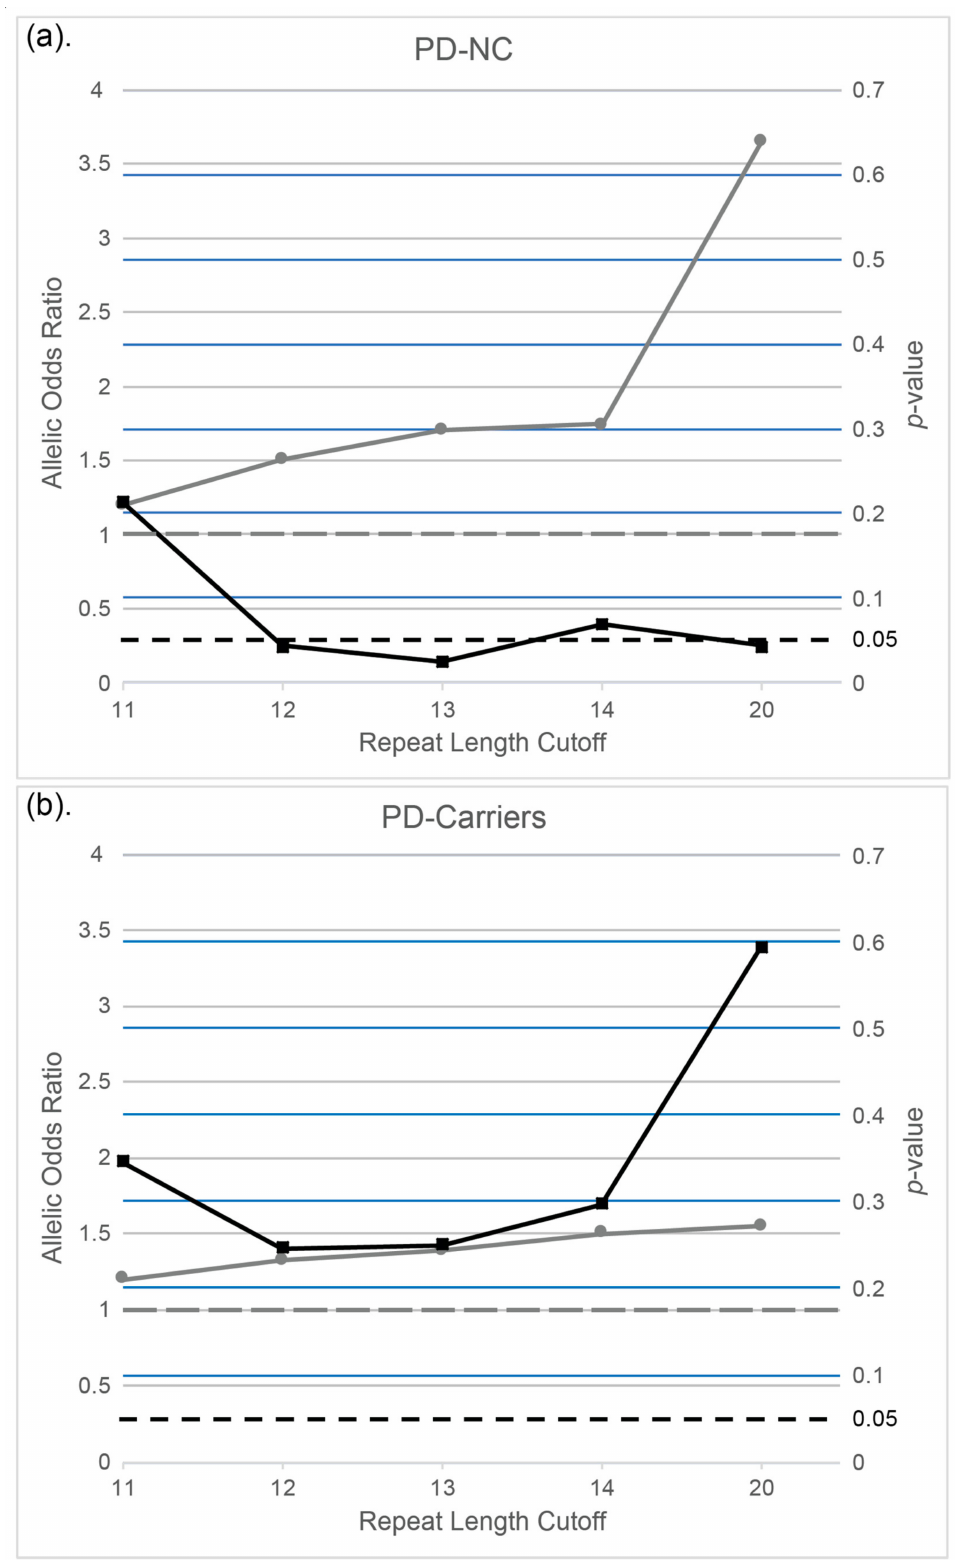
Figure 3. The effect of each cutoff of C9orf72 -repeats-size on Parkinsons’ disease risk in non-carriers of mutations (( a ), PD-NC) and in carriers of mutation (( b ), PD-Carriers; see Methods). Grey lines (circles) depict the Odds ratio and black lines (squares) depict the p -value. Dashed grey lines represent Odd Ratio of 1.0, and dashed black lines represent p -value of